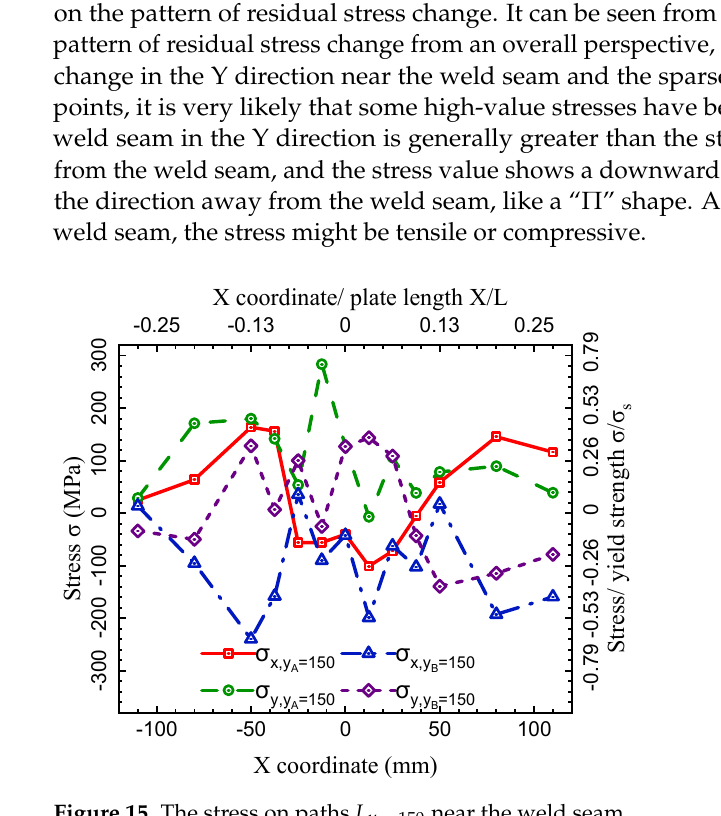
Figure 15. The stress on paths 𝐿 (cid:3052)(cid:2880)(cid:2869)(cid:2873)(cid:2868) near the weld